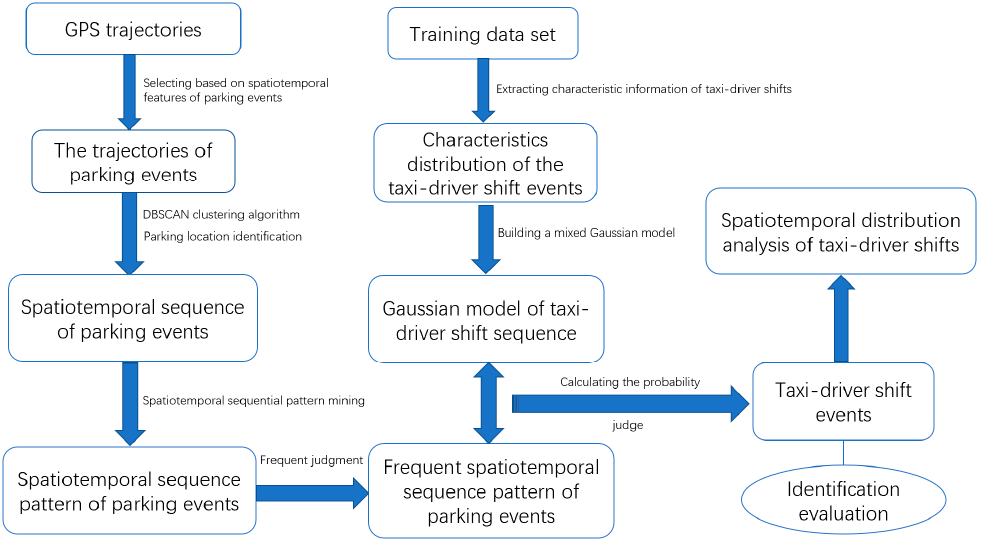
Figure 7. Experimental flowchart.